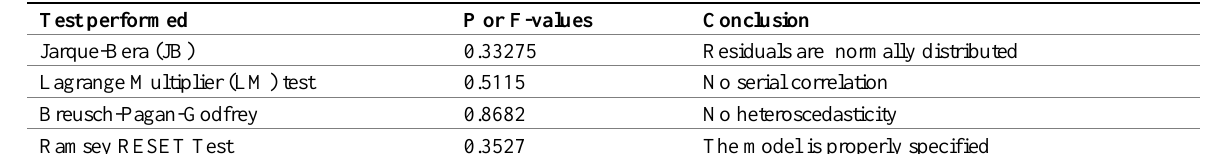
Table 7: Diagnostic stability summary of results